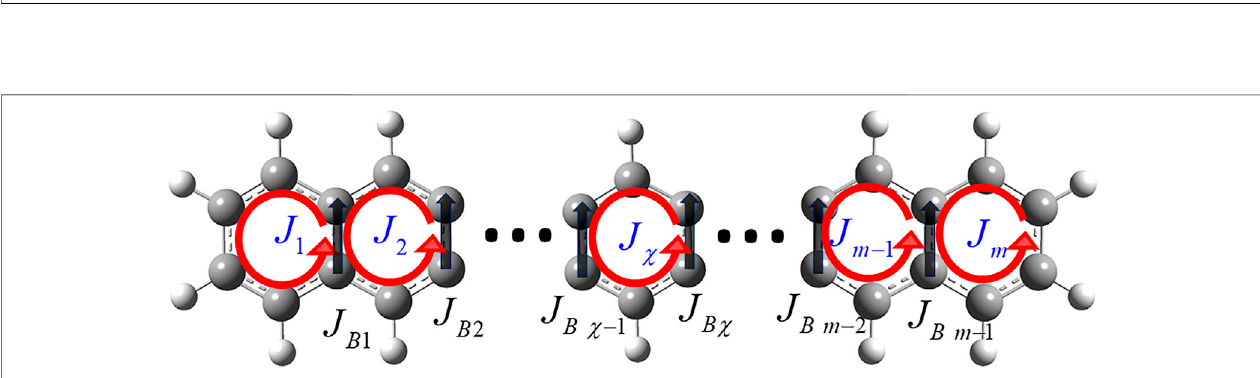
FIGURE 5 | Induced magnetic fi elds for the ( b 1 + b 2 ) electronic coherence as a function of height h measured from the center of aromatic ring K at the maximum coherence time t (cid:2) t p . B SRL K ( t p , h ) and B K ( t p , h ) represent the induced magnetic fi eld calculated by a simple ring loop model, and the fi eld calculated by the expression thatexplicitlytakesintoaccountthecoherentring currents,respectively.Theinsetpanelde fi nesthecoordinatesystemforheight h andangle η . R c denotes thecenterof the phenol ring.